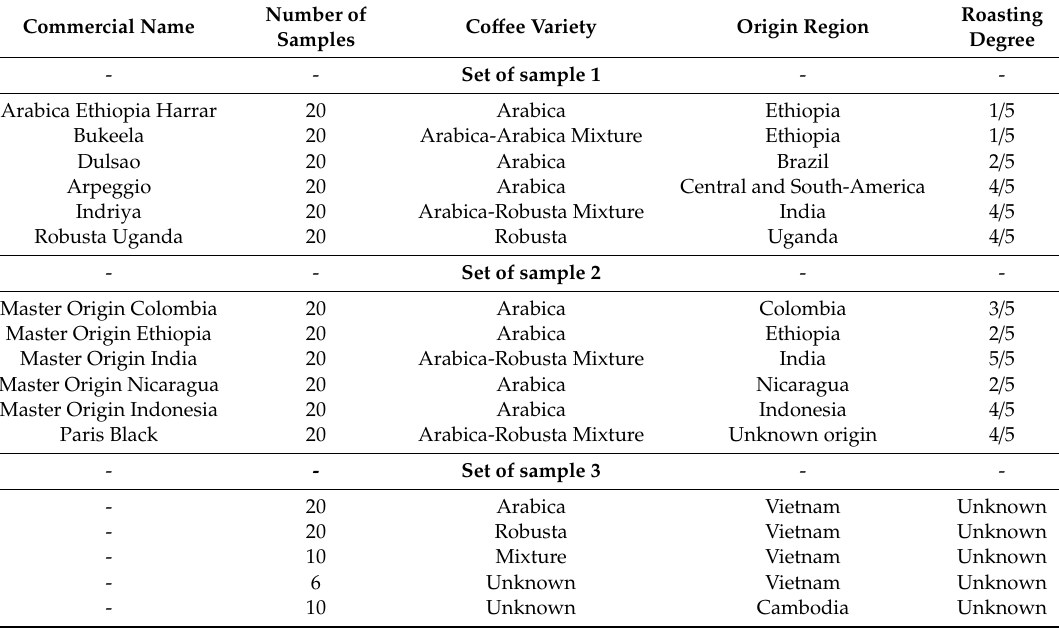
Table 1. Description of the analyzed co ff ee